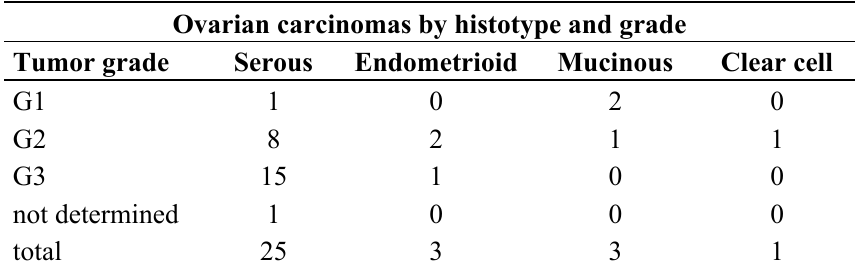
Table 2. The histological subtype and grading of studied ovarian carcinomas. Ovarian carcinomas by histotype and grade Tumor grade Serous Endometrioid